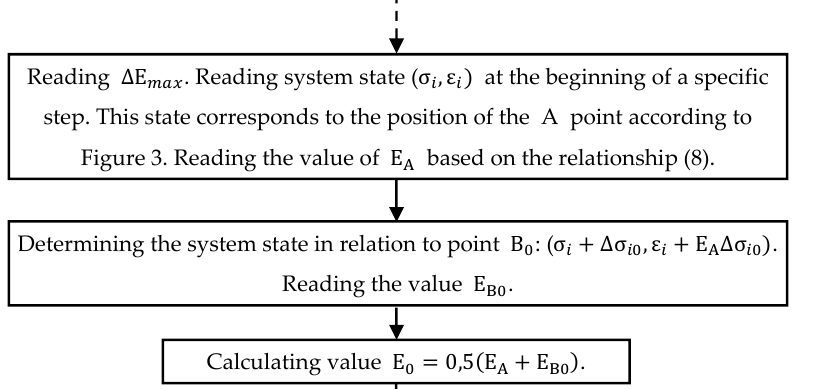
Figure 3. Reading the value of E (cid:2885) based on the relationship (8).